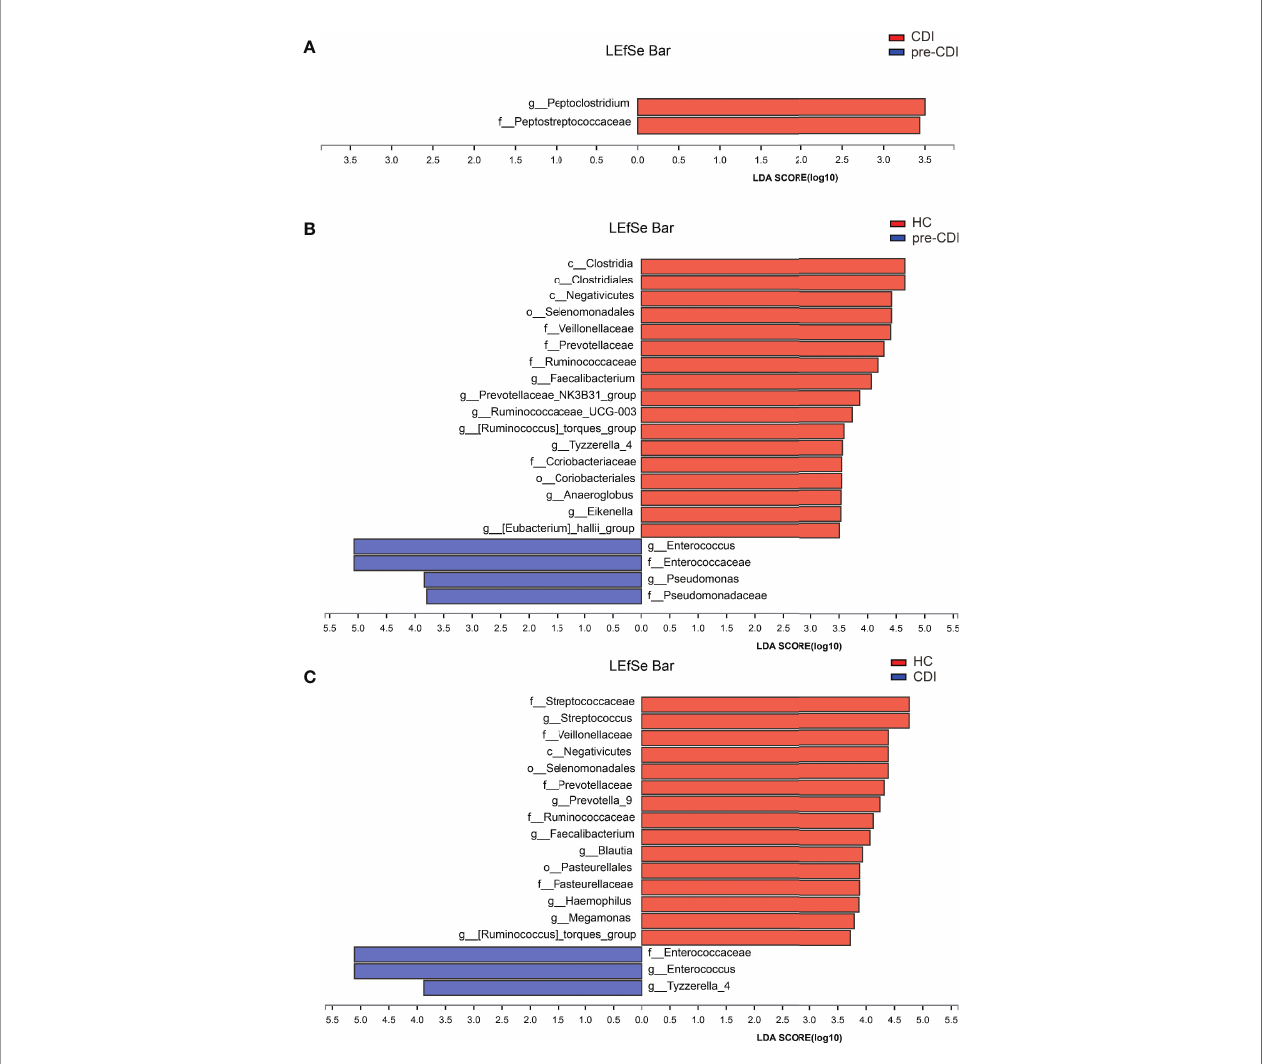
FIGURE 6 | Linear discriminant analysis effect size (LEfSe) and Linear discriminant analysis (LDA) based on operational taxonomic units characterize microbiomes in the three groups. Only taxa that meet the LDA signi fi cance threshold >3 are displayed. The enrichment degree is proportional to the LDA score. (A) LDA scores indicate signi fi cant differences in the microbiota between the pre-CDI and CDI samples. (B) LDA scores indicate signi fi cant differences in the microbiota between the pre-CDI patients and HC. (C) LDA scores indicate signi fi cant differences in the microbiota between the CDI patients and